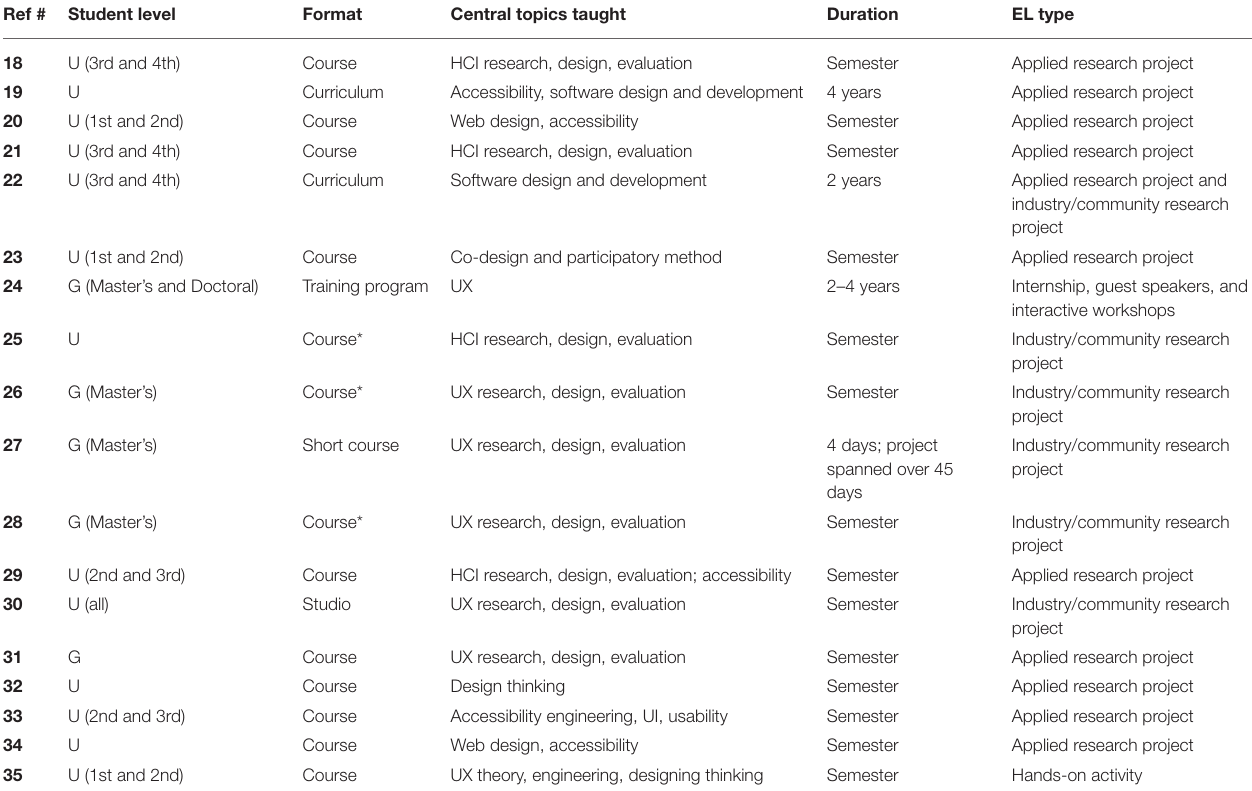
TABLE 6 | A list of EL type and respective reference.